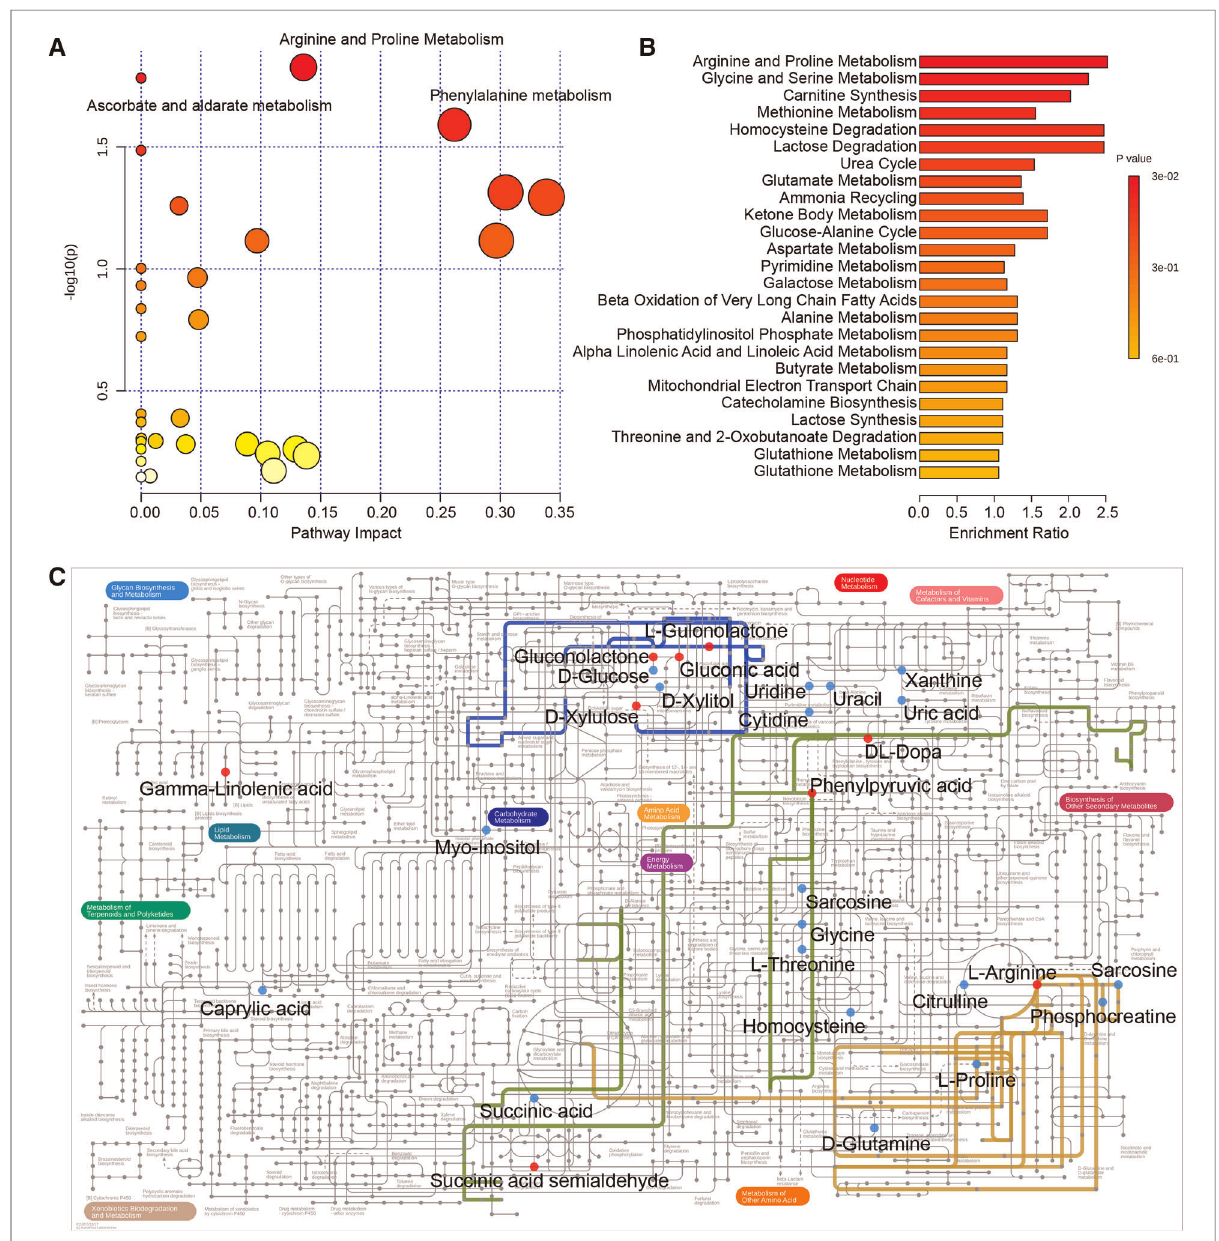
FIGURE 3 ( A ) Pathway analysis based on the KEGG database. ( B ) Enrichment analysis based on SMPDB. ( C ) Metabolic network of the crucial metabolites and signi fi cant metabolic pathways in the KEGG general metabolic pathway map. The following colored dots and lines denote the following: red dots, increased metabolites after surgery; blue dots, decreased metabolites after surgery; blue line, ascorbate and aldarate metabolism; yellow line, arginine and proline metabolism; green line, phenylalanine metabolism. KEGG, Kyoto Encyclopedia of Genes and Genomes; SMPDB, Small Molecule Pathway